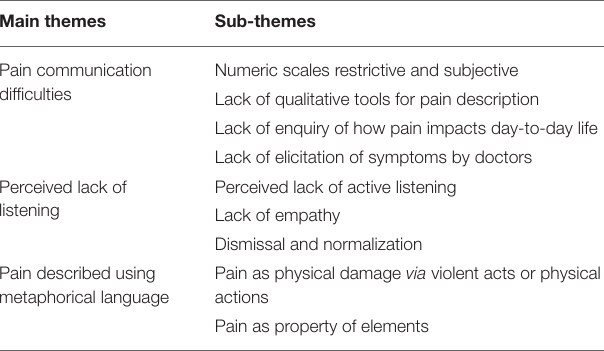
TABLE 2 | Patient views of pain communication themes and sub-themes.